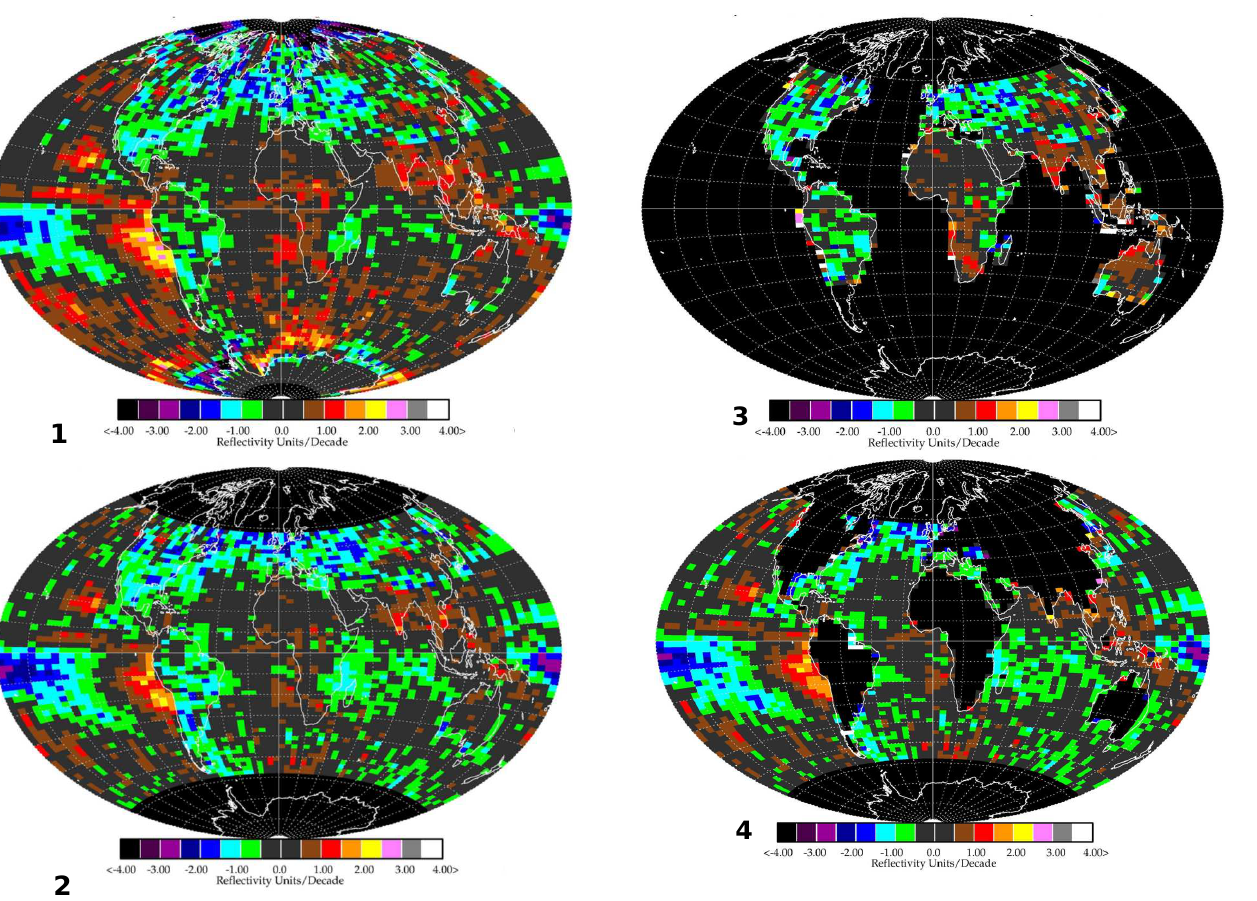
Fig. 11a. LER linear trends 1 LER( θ , ϕ) as a function of latitude θ and longitude ϕ . Each colored rectangle is the linear slope from individual time series. The upper panel 1 has no time correction applied to the data, while the lower panel 2 is based on LER nor- malized to noon using corrections derived for combined land and oceans. The noon normalization could not be applied to latitudes > 60 ◦ because of a lack of measured radiances at different local times.